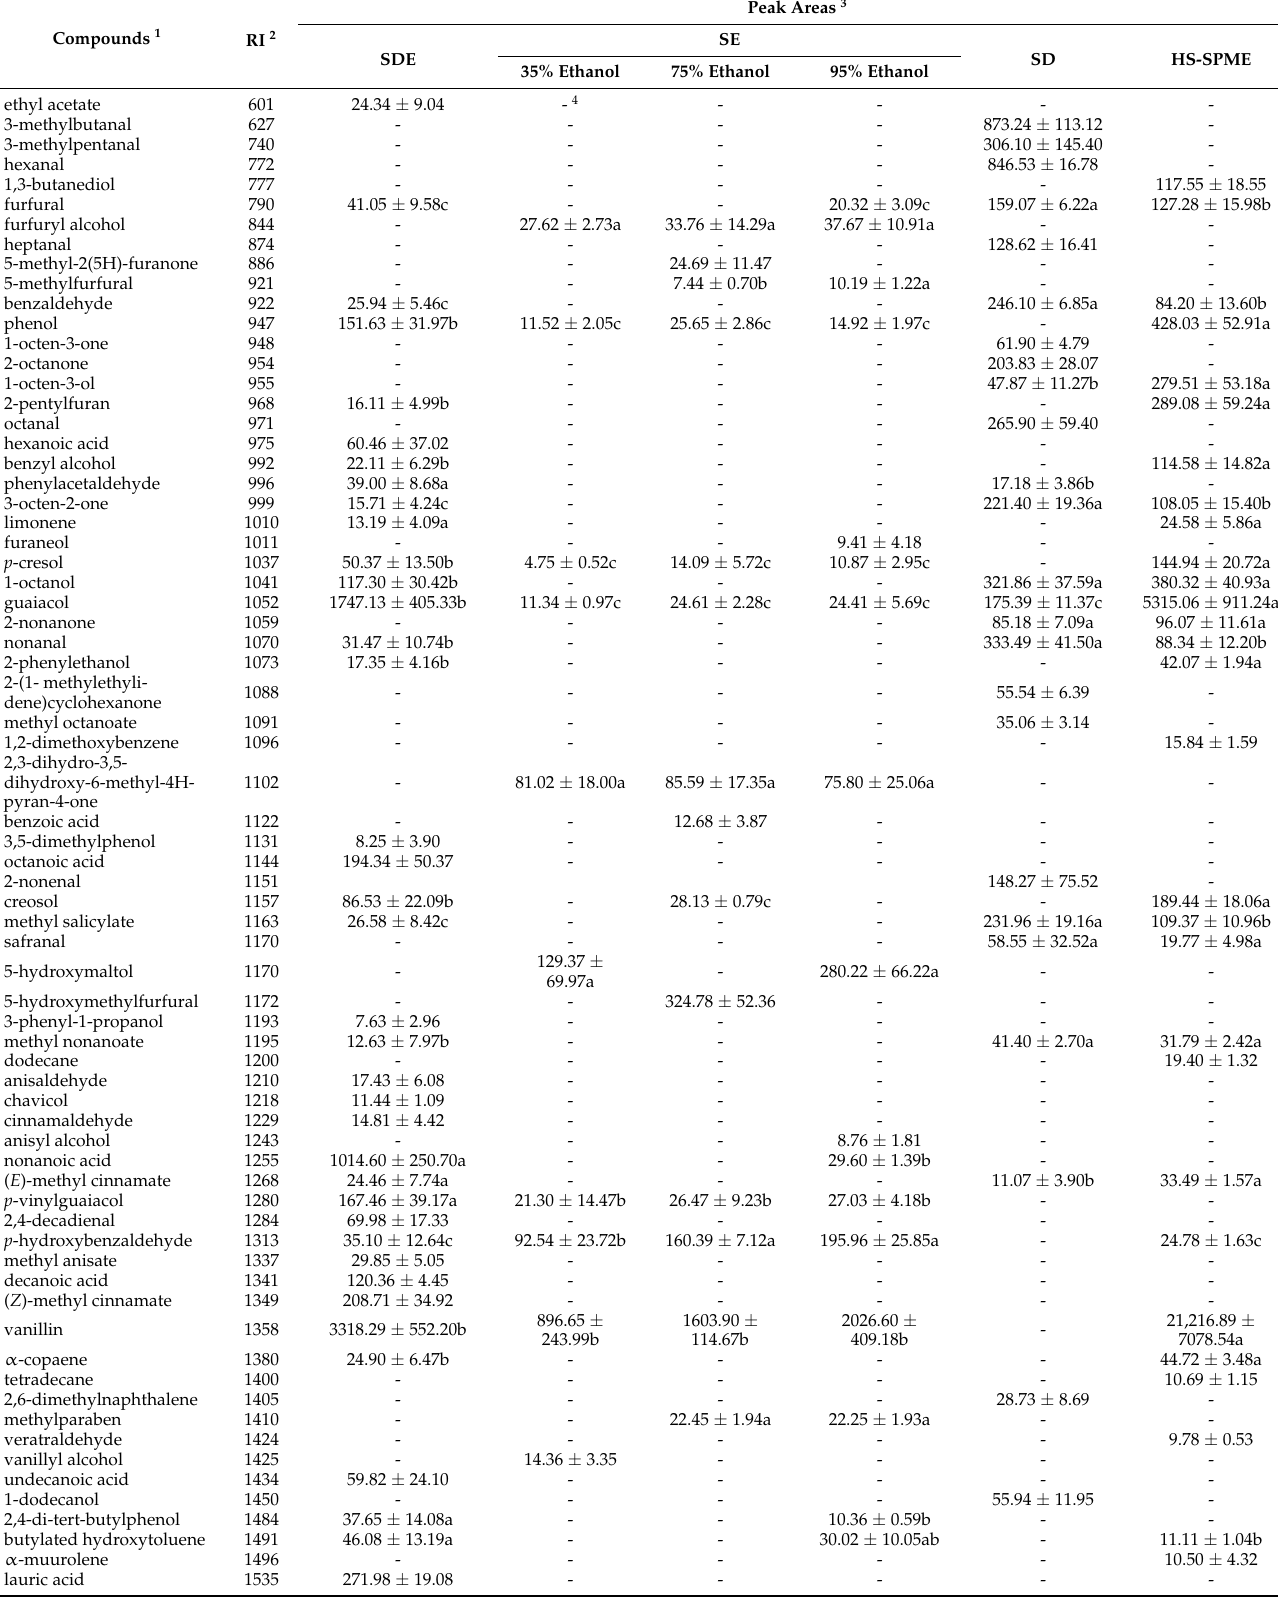
Table 2. Analysis of the volatile components of vanilla pods after different extractions